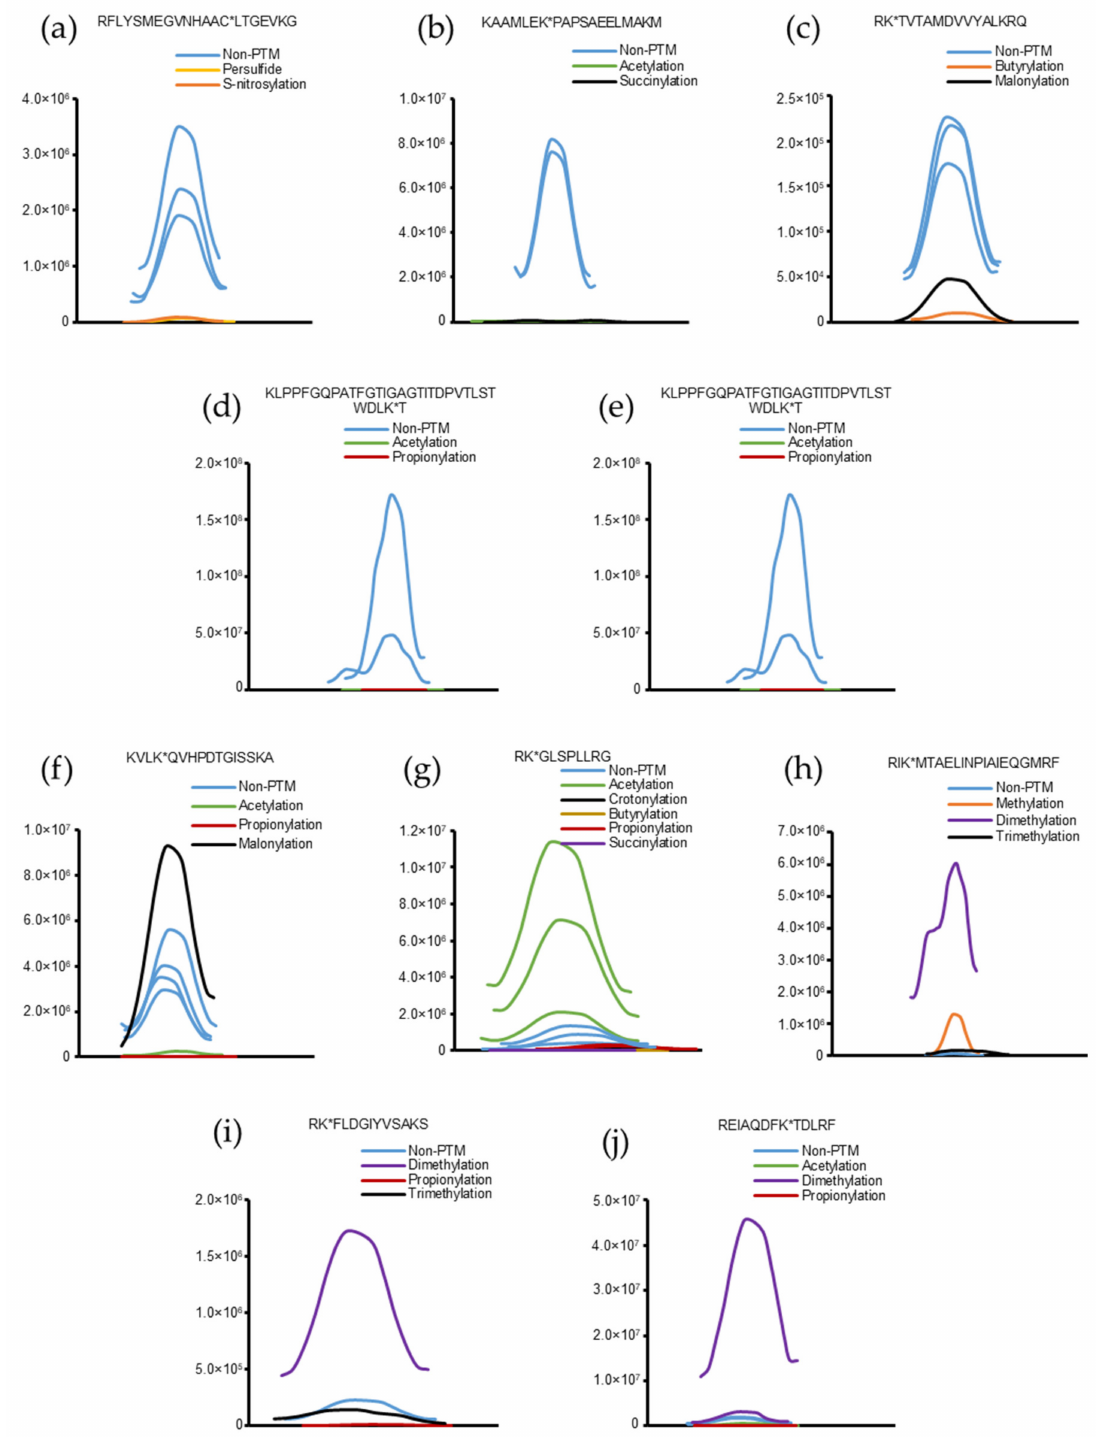
Figure 3. Representative peaks of intact and modified peptides. ( a – e ) Intact peptides have higher intensities than modi- fied peptides. ( f – j ) Modified peptides have higher intensities than intact